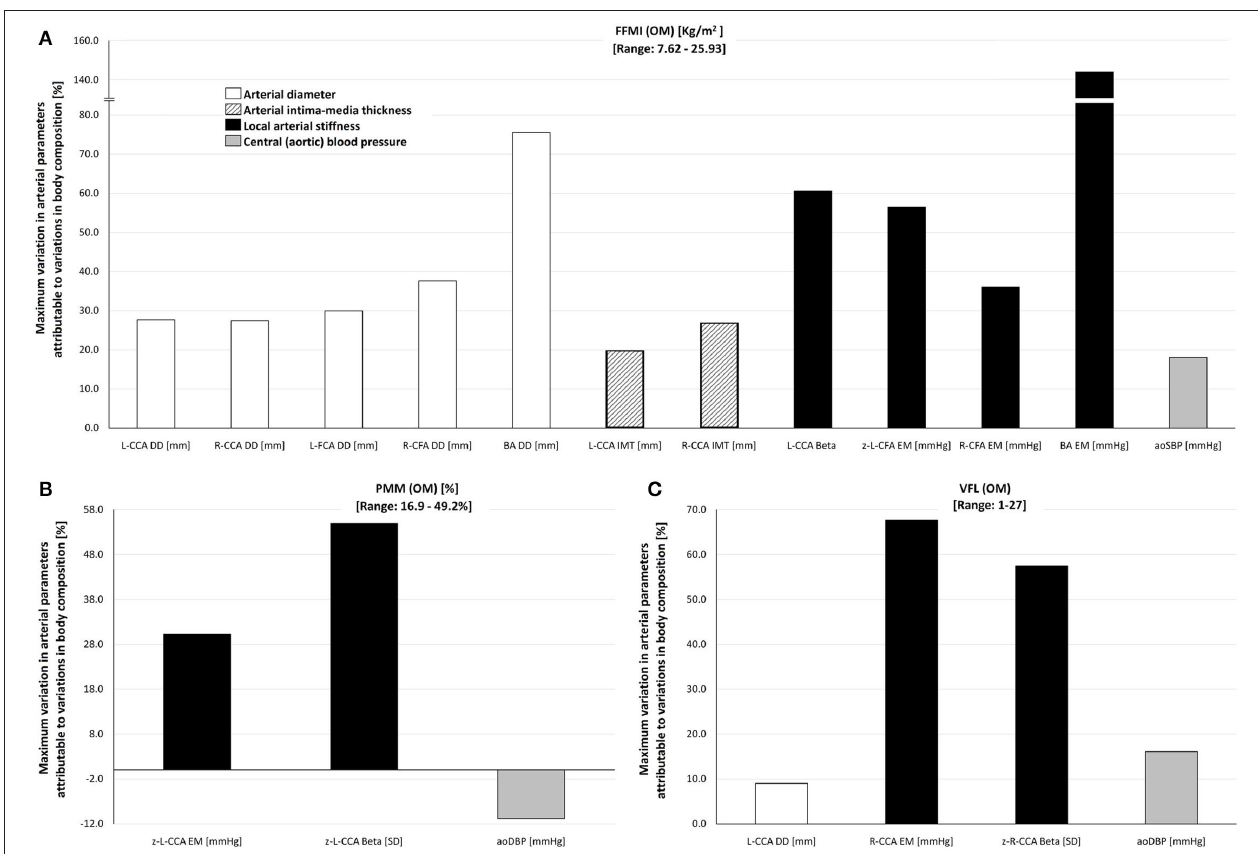
FIGURE 4 | Maximum percentage of variation of cardiovascular variables attributable to inter-individual variations in (A) FFMI (range: 7.62–25.95 kg/m 2 ), (B) PMM (range: 16.9–49.2%), and (C) VFL (range: 1–27) in the study group ( n = 538), obtained by the Omron BIA device (OM). For detailed information, see Table 3 . Abbreviations as in text.